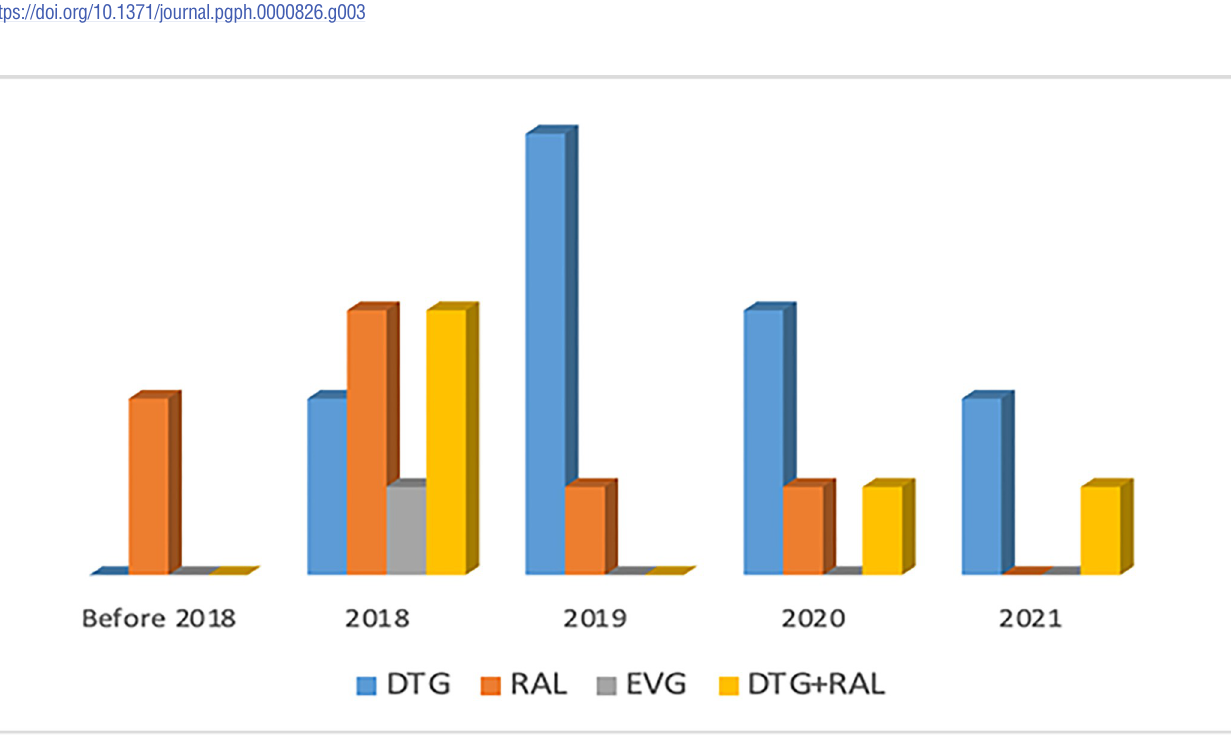
PLOS Global PublicHealth | https://doi.org/10.1371/journal.pgph.0000826 October 11,